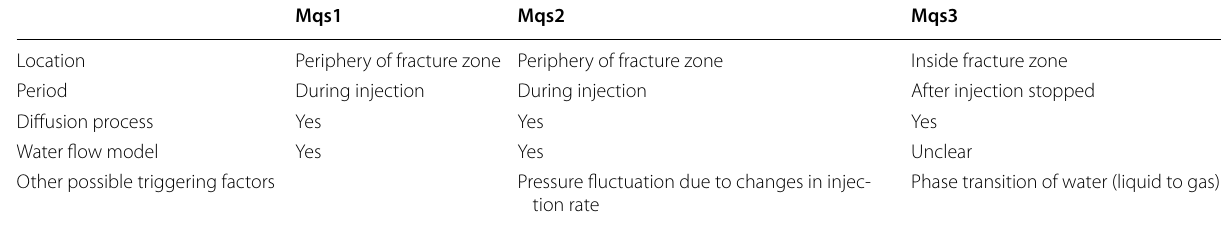
Table 1 Summary of possible triggers for Mqs1, 2, and 3 Mqs1